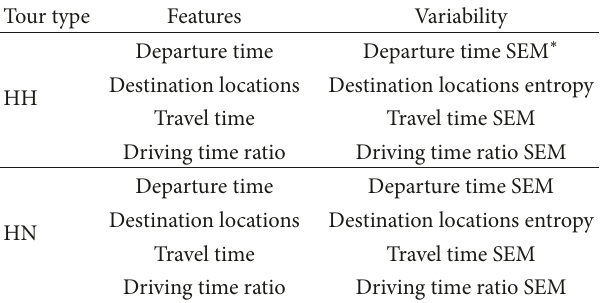
Table 1: Tour feature and variability variables